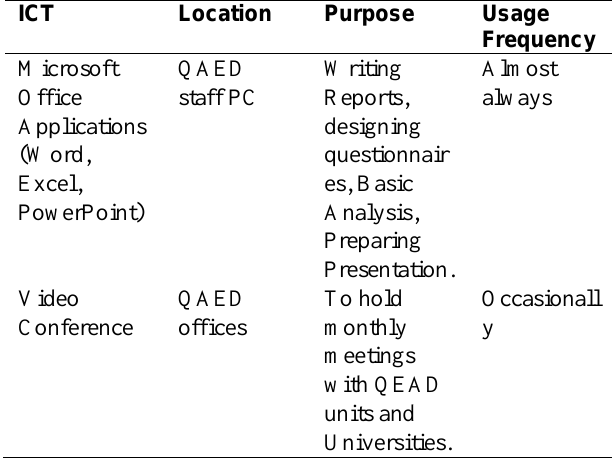
Table 8. Utilized Software in